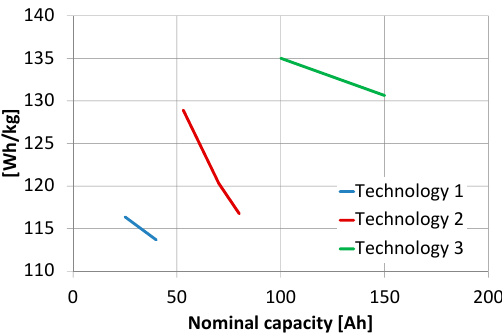
Figure 11. Gravimetric energy density of the researched Li-po batteries with a nominal voltage of 270 V.